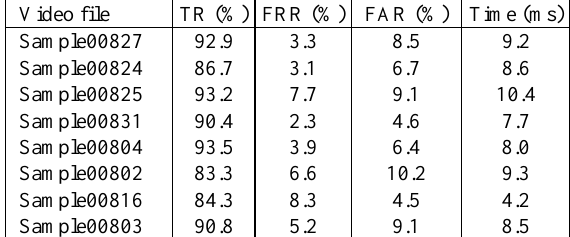
Table 2. Gesture segmentation results and temporal estimators